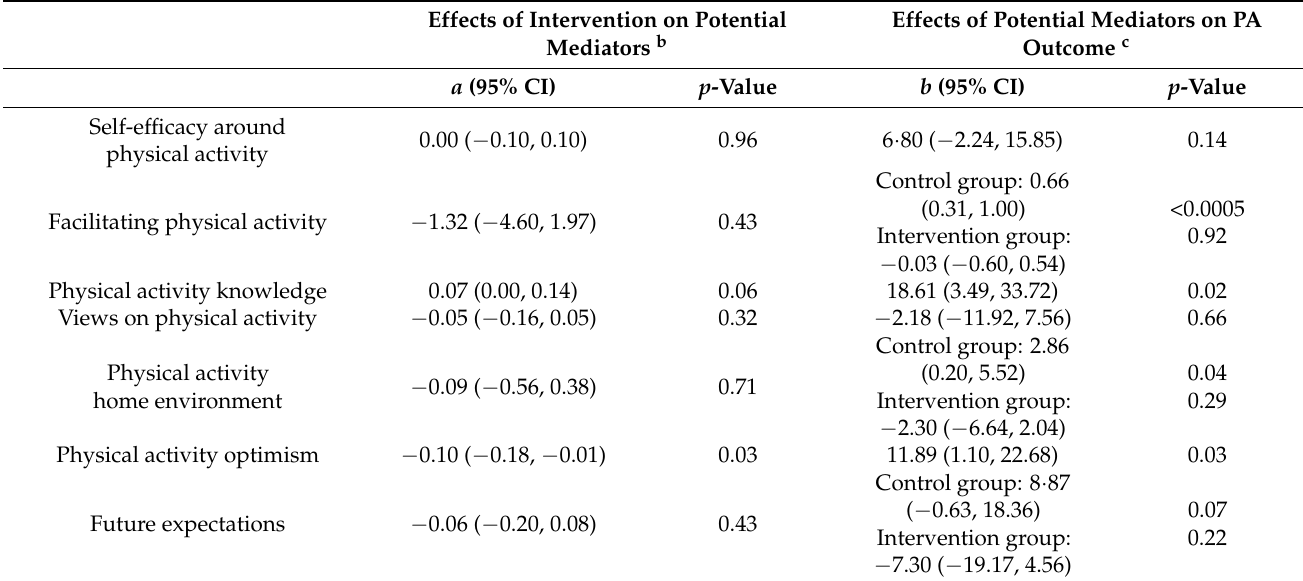
Table 2. Mediating pathways between the intervention group, potential mediators and children’s physical activity time a